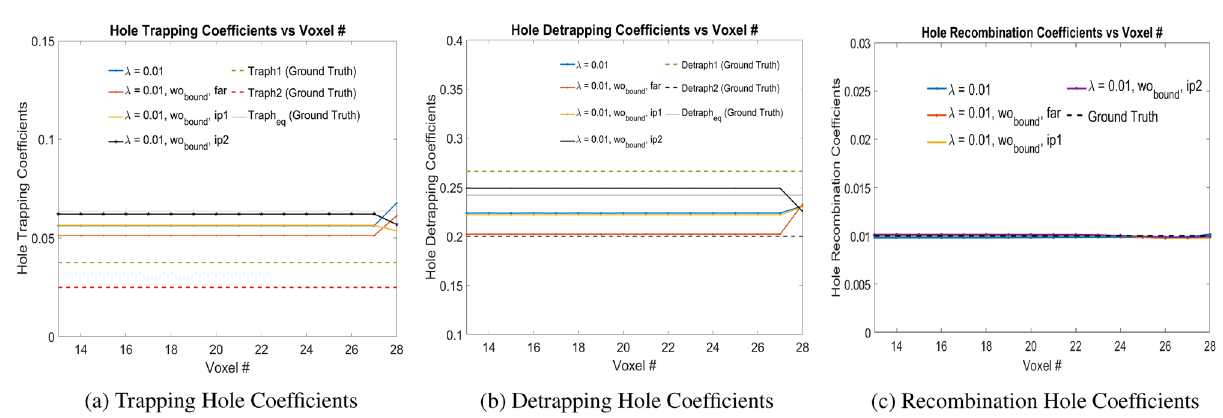
Figure 10. Trapping, Detrapping and Recombination Hole Coefficients for hole injection at Voxels 24, 26 and 28 in Physical Model-4 with (cid:31) = 0.01 values as shown in the legend. Here (cid:31) refers to (cid:31) 2 in Eq. (9). Readers are suggested to enlarge the figure for closer